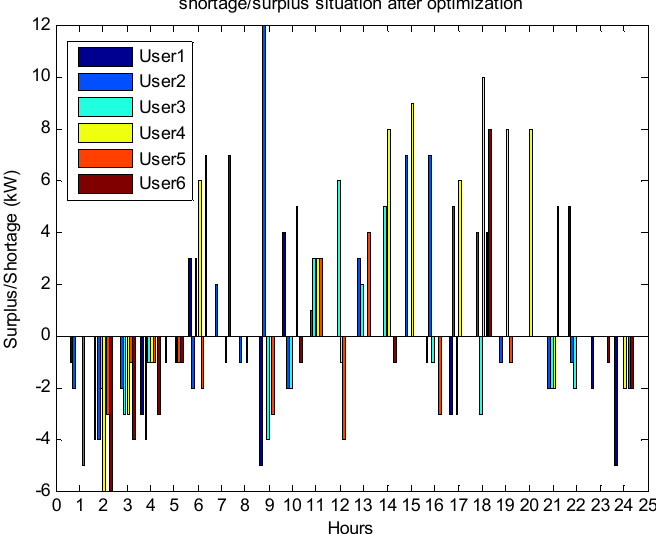
Figure 6. Shortage and surplus energy after the